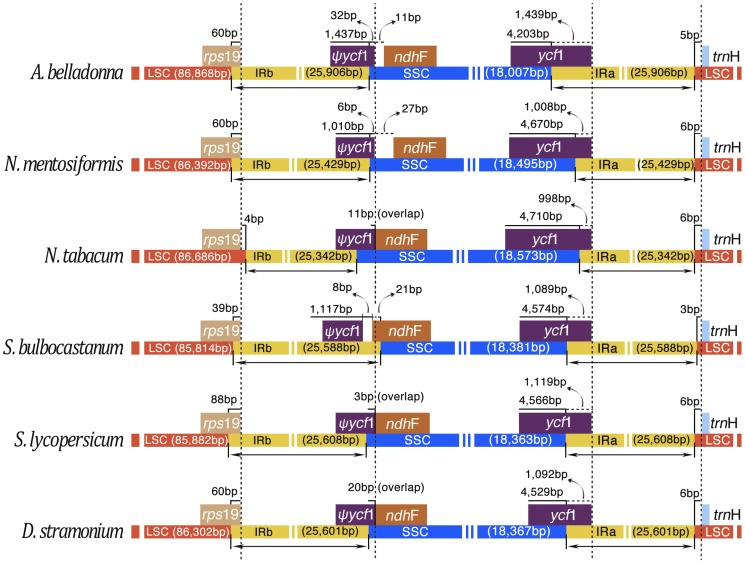
Comparison of the borders of LSC, SSC and IR regions among six chloroplast genomes.The IRb/SSC border extended into the ycf1 genes to create various lengths of ycf1 pseudogenes among six chloroplast genomes. The ycf1 pseudogene and the ndhF gene overlapped in the N. tabacum, S. lycopersicum and D. stramonium cp genomes from 3 bp to 20 bp, respectively. Various lengths of rps19 pseudogenes were created at the IRa/LSC borders except N. tabacum. This figure is not to scale.